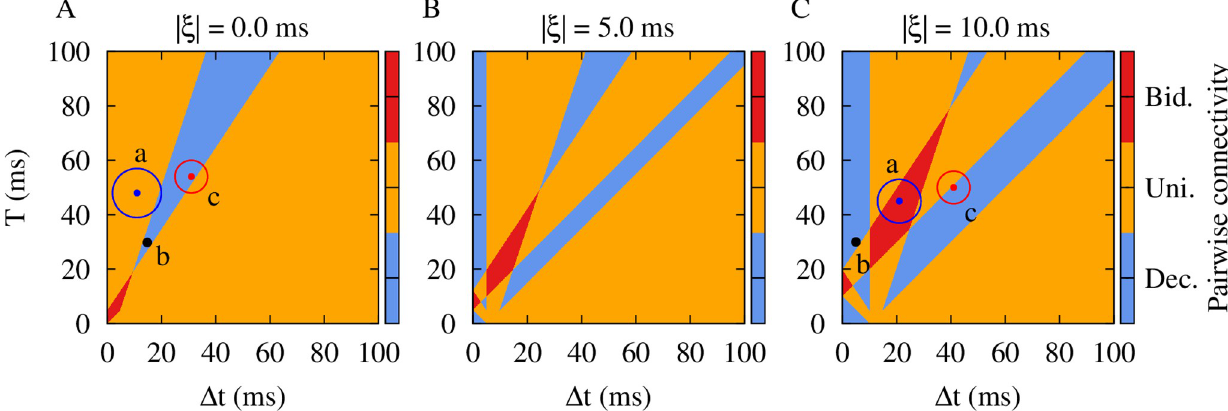
Fig 2. Theoretical prediction of the emergent two-neuron connectivity. Qualitative colors show the synaptic structure between a pair of pre- and postsynaptic neurons calculated based on the synaptic change in Eq (5) over a period ( T ): Decoupled (blue), unidirectional (orange) and bidirectional (red) regimes. STDP parameters were A + = 0.008, A − = 0.005, τ + = 10 ms and τ − = 20 ms. ( A ) Points a: (11, 48) ± 9 ms, b: (15, 30) ms and c: (31, 54) ± 6 ms represent ( Δ t , T ) pairs obtained from simulations performed in S1 Fig before, during and after the stimulation, respectively, for | ξ | = 0.0 ms. ( B ) | ξ | = 5.0 ms; the effective delay at synapse reshapes the Δ t - T plane. ( C ) Points a: (21, 45) ± 8 ms, b: (5, 30) ms and c: (41, 50) ± 6 ms show the same ( Δ t , T ) pairs as in A, but obtained from numerical simulations performed in Fig 3 before, during and after the stimulation, respectively, for | ξ | = 10.0 ms.